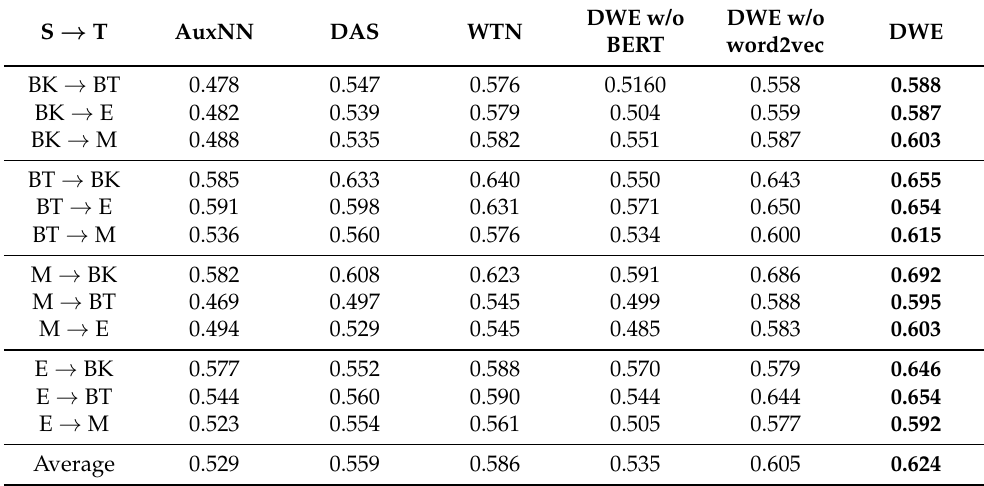
Table 4. Classification accuracy of various models on Dataset 2.